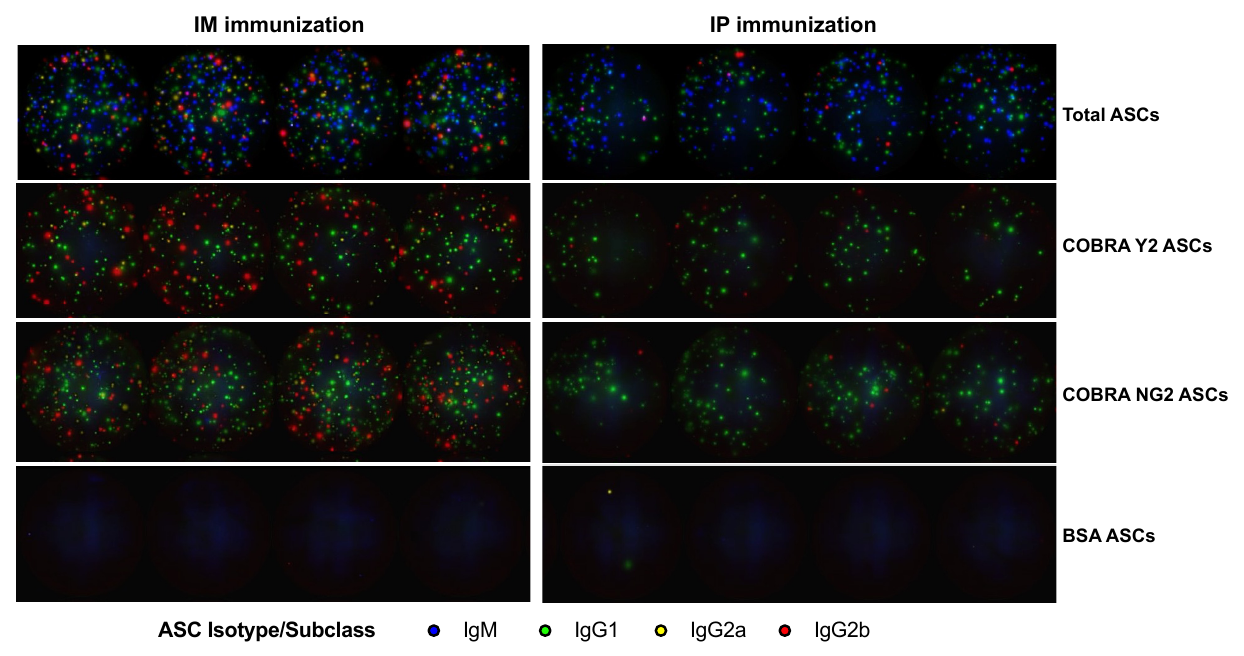
Figure 5. Representative FluoroSpot wells acquired from a 96-well plate for total (1.25 × 10 4 spleno- cytes input/well), COBRA Y2 (7.5 × 10 4 splenocytes input/well), COBRA NG2 (7.5 × 10 4 splenocytes input/well) and BSA (3 × 10 5 splenocytes input/well) ASCs from splenocytes collected following the final vaccine boost of mice through IM (left panels) or the IP (right panels) route using the combination of COBRA Y2 and NG2 rHAs. Represented wells were obtained from splenocytes collected at day 9 (for the IM-immunized group) and at day 5 (for the IP-immunized group) from one repre- sentative animal and run as quadruplicates.